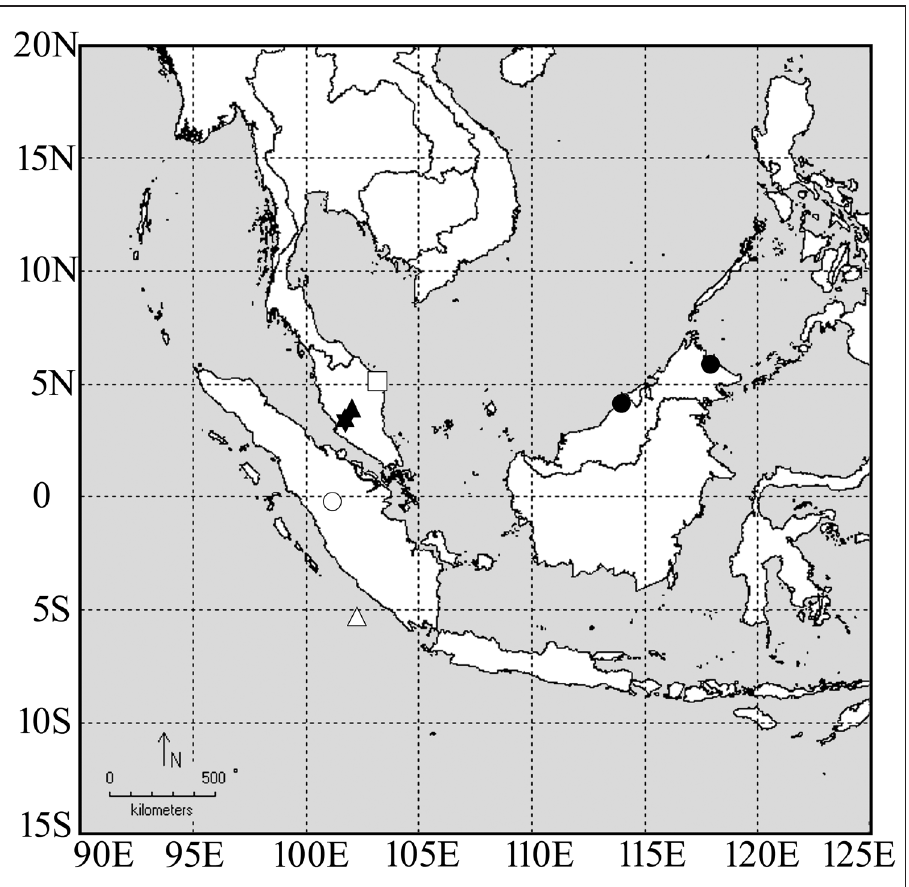
Figure 3. Collecting localities of species of the modiglianii species group. Black star: L. breviloba and L. itoi , white circle: L. curva , black triangle: L. itoi , black circle: L. kanaoi , white rectangle: L. malayana , white triangle: L. modiglianii